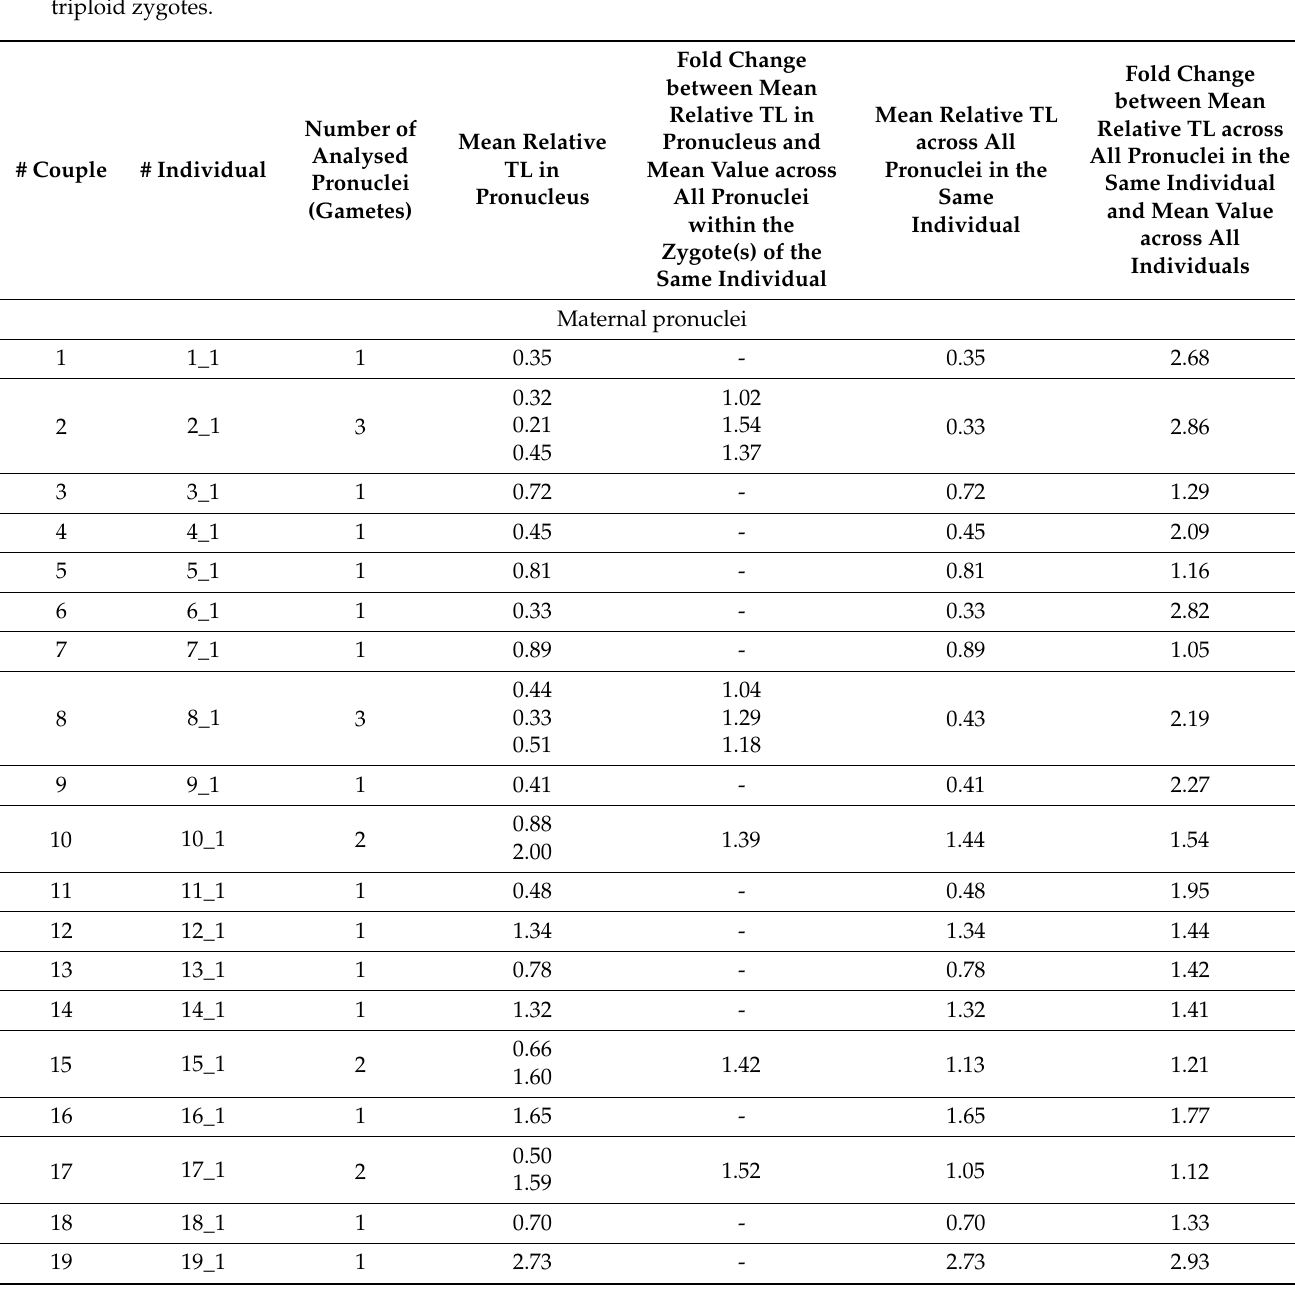
Table 2. Telomere length (TL) characteristics in chromosomes from the maternal and paternal pronuclei of human triploid